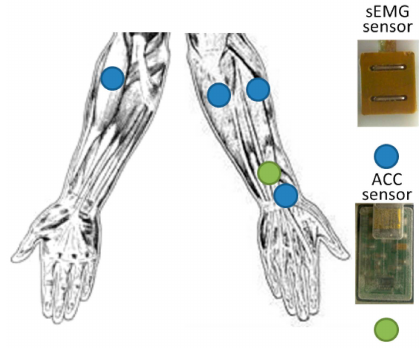
Figure 2. Positions of sEMG and ACC sensors on the right